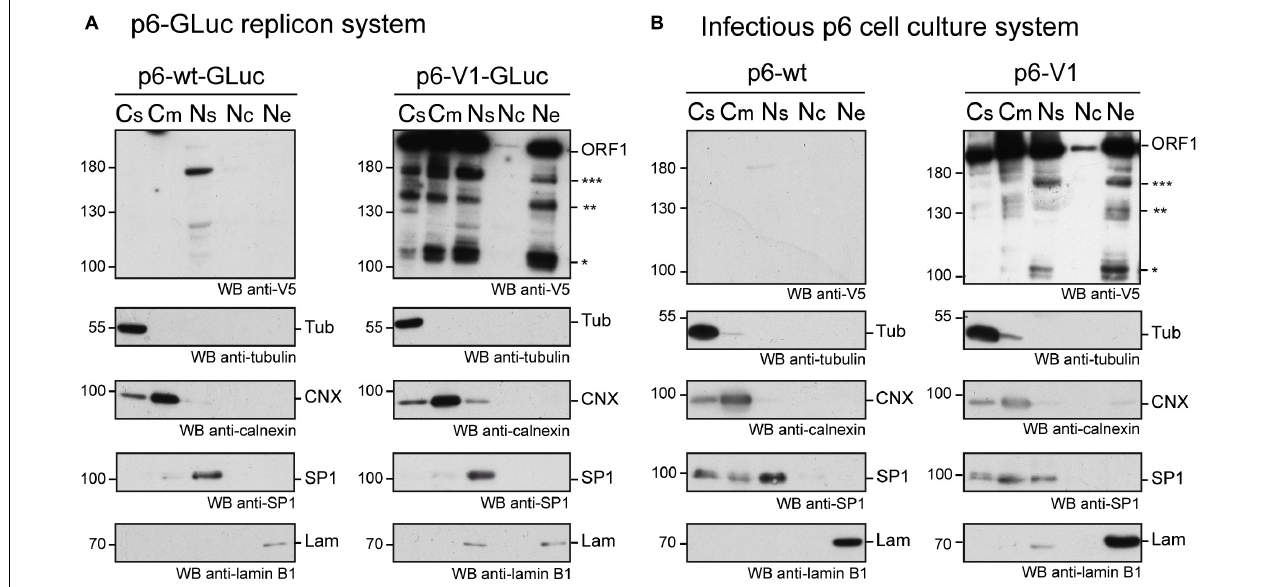
FIGURE 5 | The ORF1 protein is expressed in different cellular compartments. (A) PLC3 cells were electroporated with the p6-GLuc replicons expressing the non-tagged wildtype ORF1 (p6-wt-GLuc), and the V5-tagged ORF1 (p6-V1-GLuc). Three dpe, cells were collected and cellular fractions were separated as follows: Cs, cytoplasmic soluble fraction; Cm, cytoplasmic membranous fraction; Ns, nuclear soluble fraction; Nc, nuclear chromatin-bound fraction; Ne, Nuclear envelope. Immunoblots were probed with a mouse monoclonal antibody directed against the V5 epitope. Other antibodies were used to monitor for fraction enrichment: anti- γ -tubulin as a marker of the cytoplasmic soluble fraction, anti-calnexin as a marker of cytoplasmic membranous fraction, anti-SP1 as a marker of nuclear soluble fraction and anti-lamin B1 as a marker of nuclear envelope. Molecular weight markers are indicated in kilodaltons. Stars indicate lower molecular weight ORF1 products. (B) PLC3 cells were electroporated with the p6 expressing the non-tagged wildtype ORF1 (p6-wt), and the V5-tagged ORF1 (p6-V1). Four hpe, cells were collected and cellular fractions were separated and named as above. The above-mentioned antibodies were used to reveal the immunoblots. Molecular weight markers are indicated in kilodaltons. Stars indicate lower molecular weight ORF1